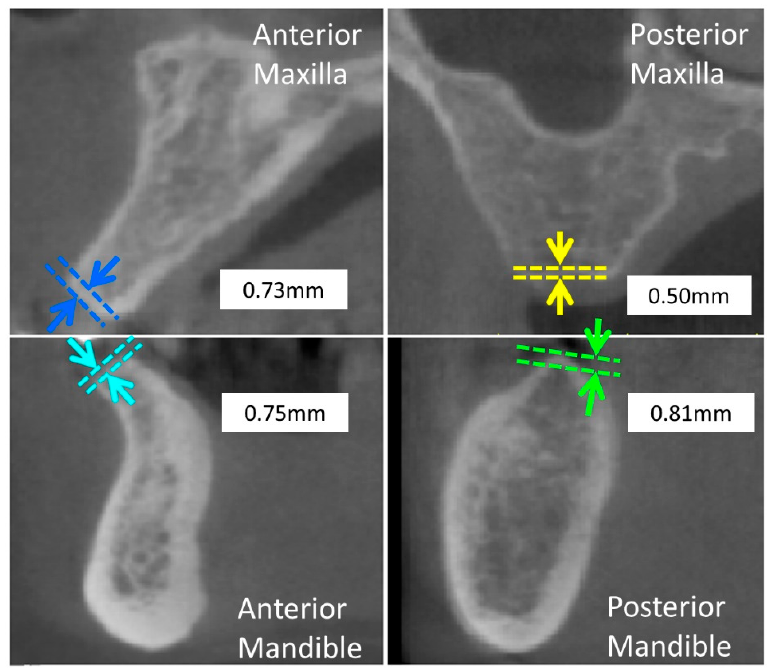
Figure 1. Thickness of crestal cortical bone at the dental implant site for the four jawbone regions, measured using cone-beam computed tomography (CBCT) images.